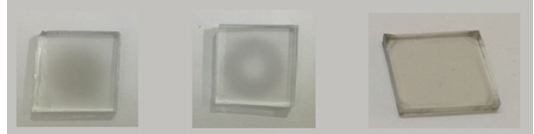
Figure 6. Pt/FTO photographs of: a. (PtL), b. (PtS), and c.